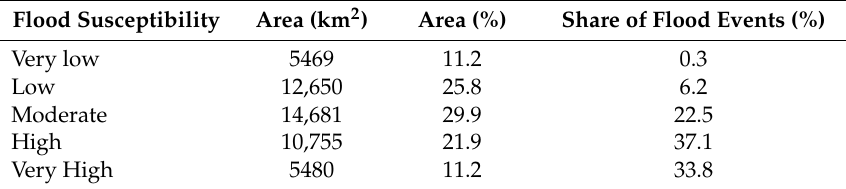
Table 5. Area coverage of flood susceptibility classes and share of flood events corresponding to the defined flood susceptibility classes.